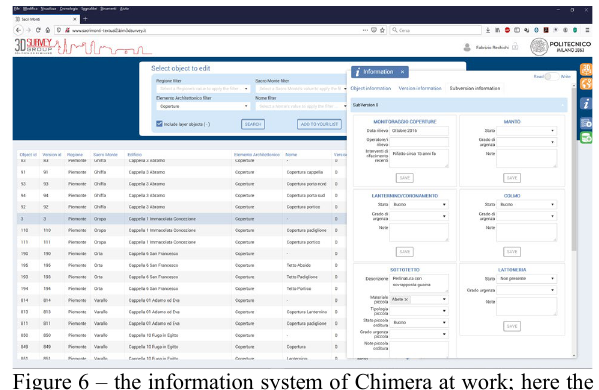
Figure 6 – the information system of Chimera at work; here the textual component is used to select the object, but the information would be the same from the